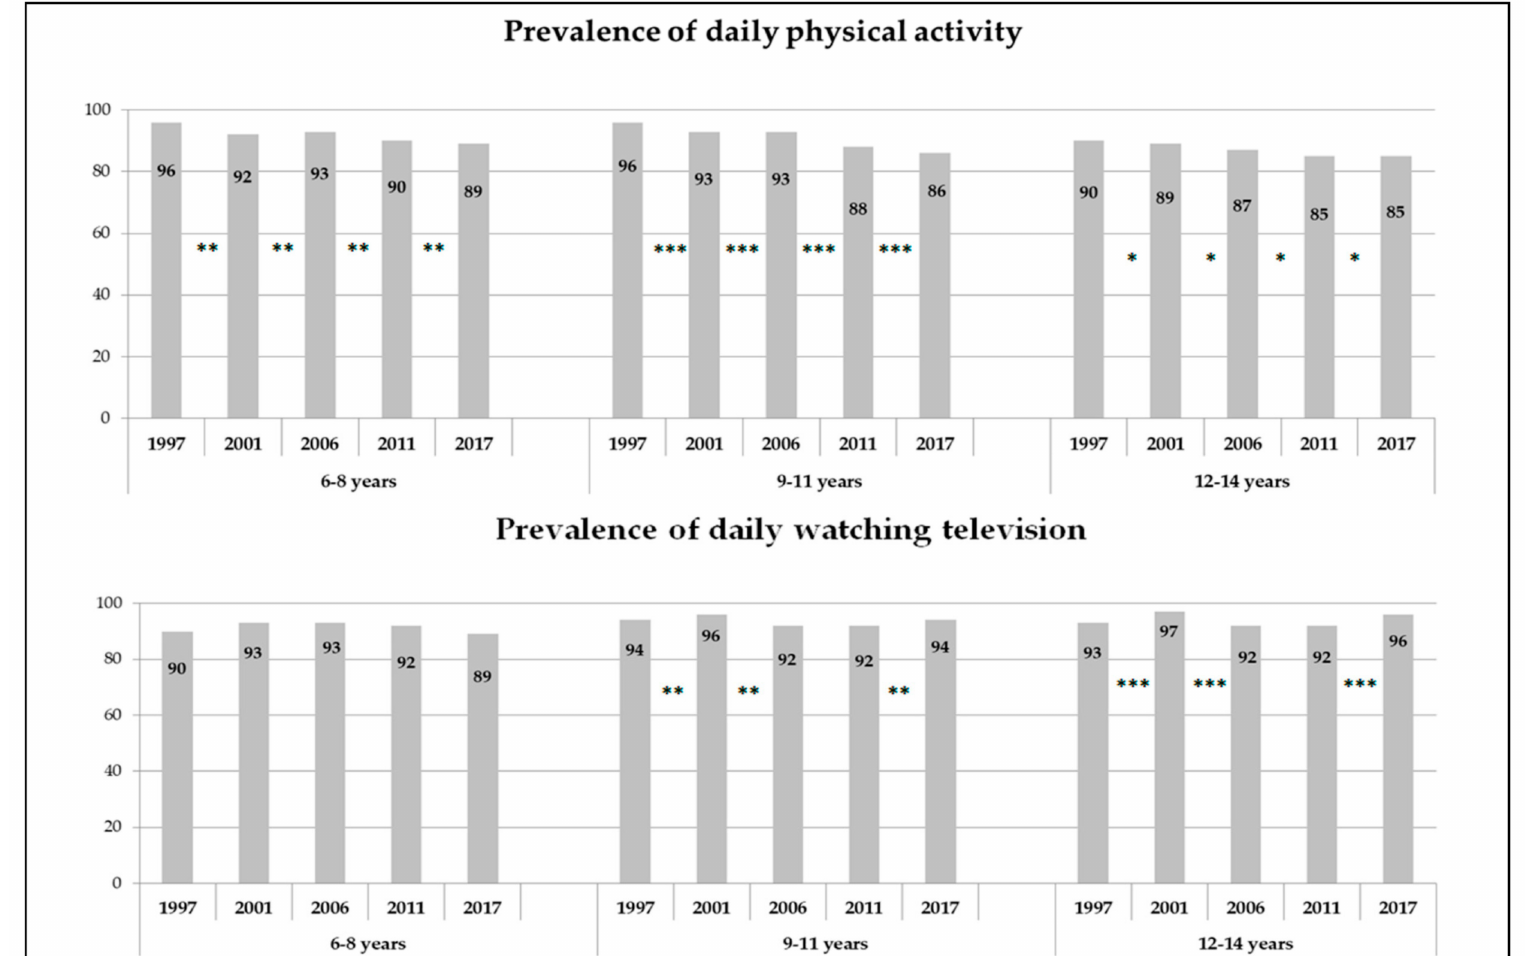
Figure 1. Prevalence evolutions of the habits of physical activity and television viewing (data provided: percentage) (Asterisks represent the ANOVA results between two consecutive surveys: * p < 0.05; ** p < 0.01; *** p <